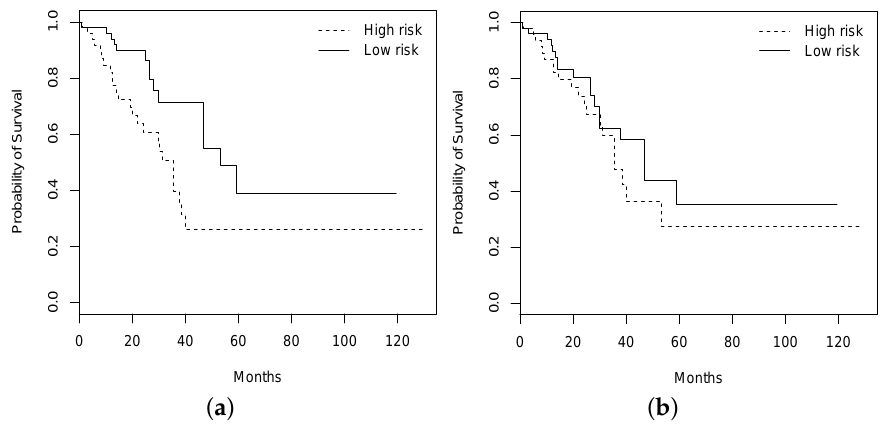
Figure 2. Kaplan–Meier curves of high and low risk groups identified by the approach that accommodates interactions (( a ); logrank test p -value 0.007) and the one with main effects only (( b ); logrank test p -value 0.320). Table 4. Joint analysis of overall survival: identified main effects and